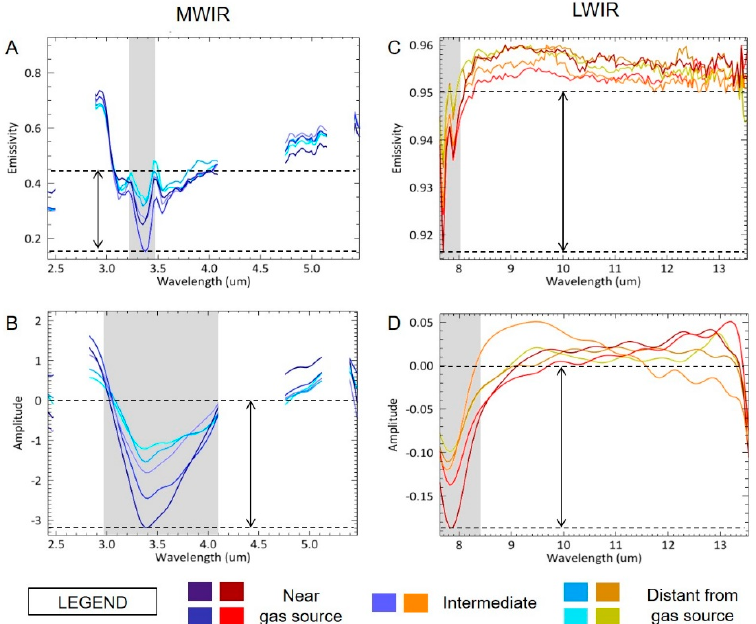
Figure 8. Comparison between spectral signatures extracted from the same pixels. ( A , C ): images in emissivity units. ( B , D ): images transformed to the wavelet domain. The spectra were extracted from the CH 4 plume formed from Leak 5 from MWIR ( A , B ) and LWIR ( C , D ) images. Areas in grey outline the CH 4 features centered at 3.3 µm and 7.7 µm in the respective plots. Spectra were interrupted within regions highly affected by atmospheric interference. The wavelet decreased the noise and increased the contrast between the plume and the background (indicated by the black arrows in the plots). The same improvements were noticed in the spectral collection extracted in other leakage stations.